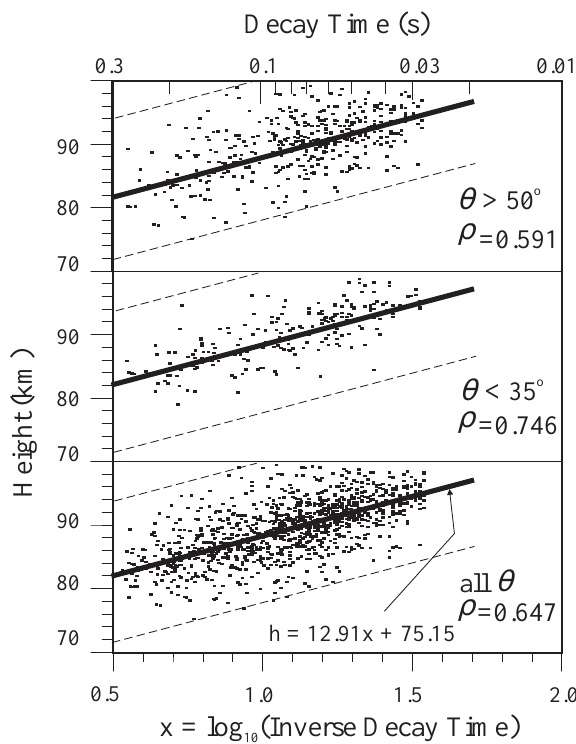
Fig. 1. Typical plots of log 10 (inverse decay time) as a function of height for (a) meteors with zenith angles between 50 ◦ and 70 ◦ , (b) zenith angles less than 35 ◦ , and (c) zenith angles between 0 ◦ and 70 ◦